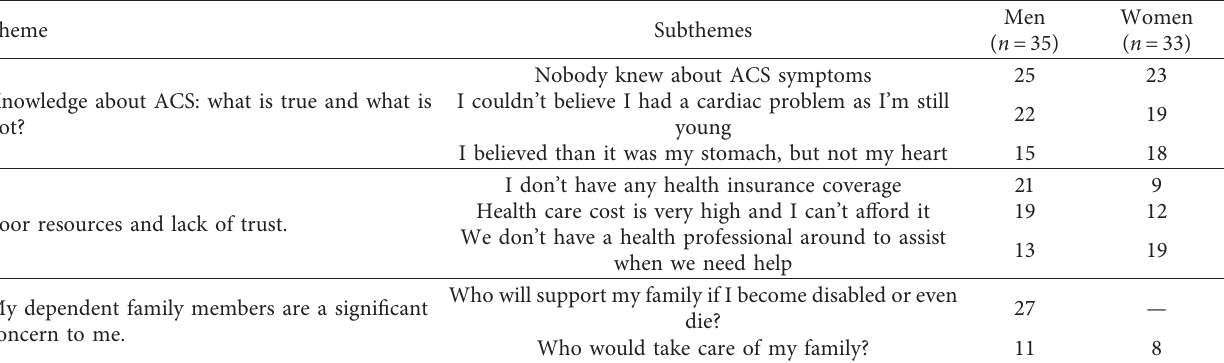
Table 4: Themes reflecting reasons for prehospital delay among ACS patients.